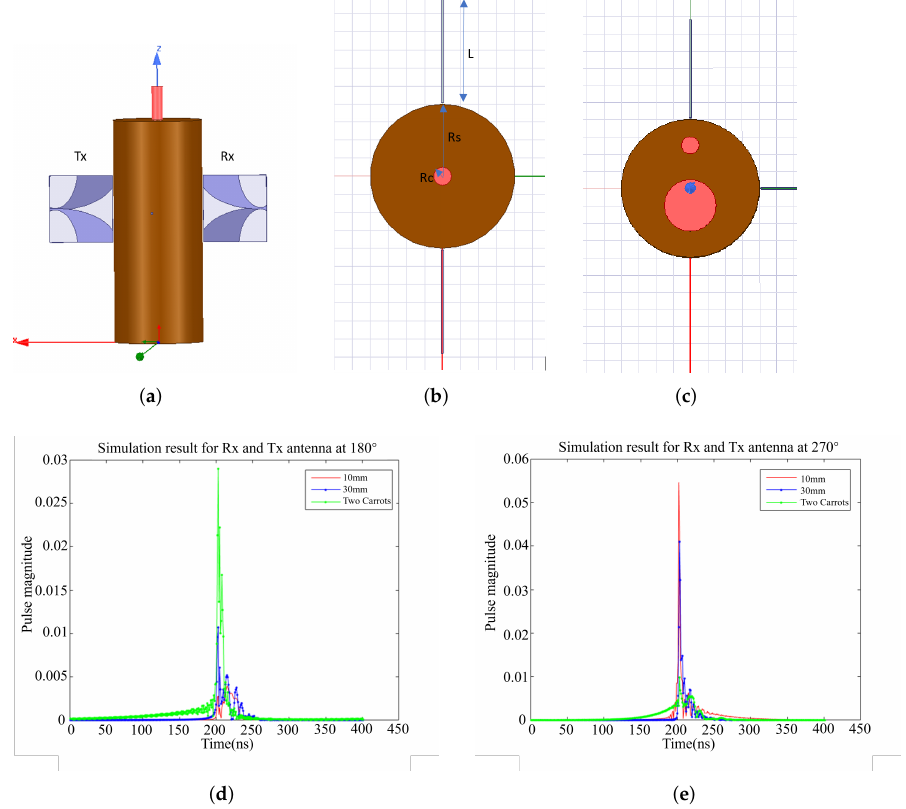
Figure 3. Schematic of the HFSS simulation showing ( a ) side view of a container with soil and a carrot and the location of the launcher and receiver antennas, ( b ) top view showing a container with soil and a single carrot and ( c ) top view showing a container with soil and two carrots. The time-domain results for the antennas at ( d ) 180 ◦ and ( e ) 270 ◦